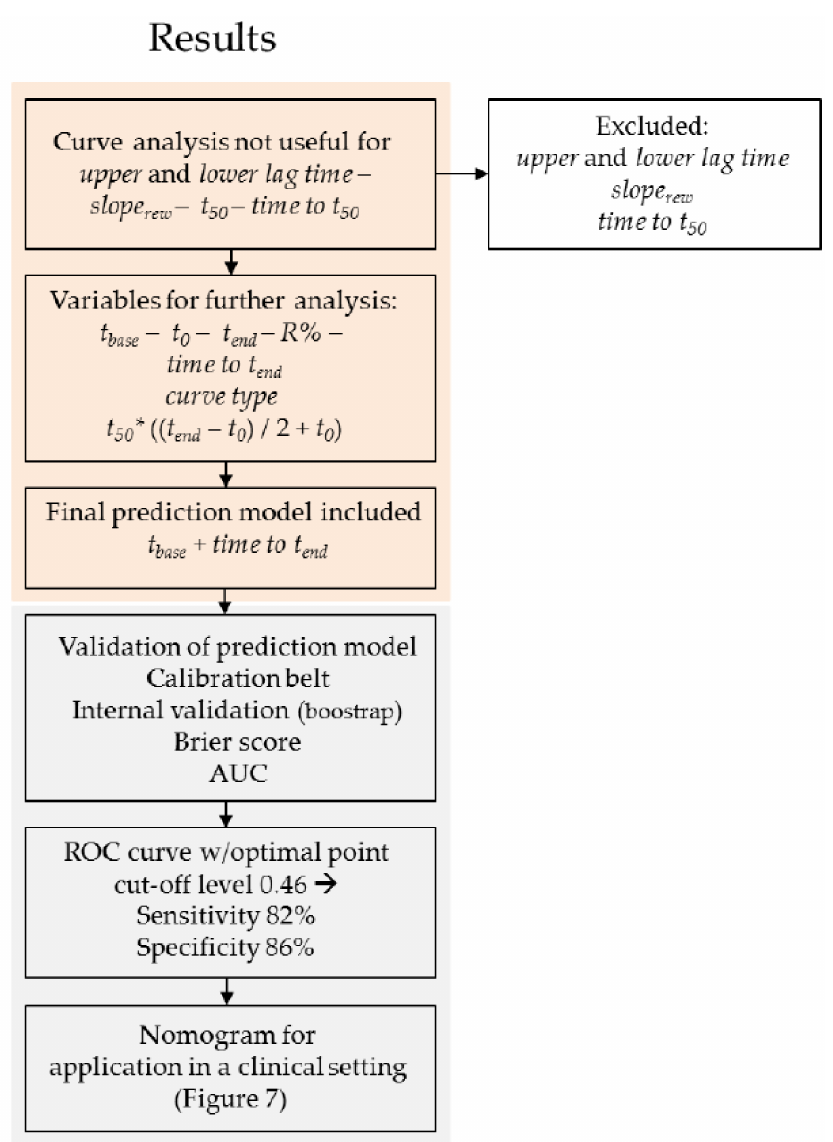
Figure 8. Flowchart of the results generated from the analysis of rewarming curves, fitting of predic- tion model (both orange section), and validation of the model as well as the subsequent calculation of the proposed cut-off level and construction of the nomogram (gray section). The orange section corresponds to the orange section of Figure 3. slope rew = slope of the curve during rapid rewarming; t 50 = finger temperature halfway through rewarming; t base = baseline finger temperature; t 0 = fin- ger temperature immediately after cooling; t end = end temperature; R% = percentage temperature recovery at end temperature; t 50 * = finger temperature halfway through rewarming